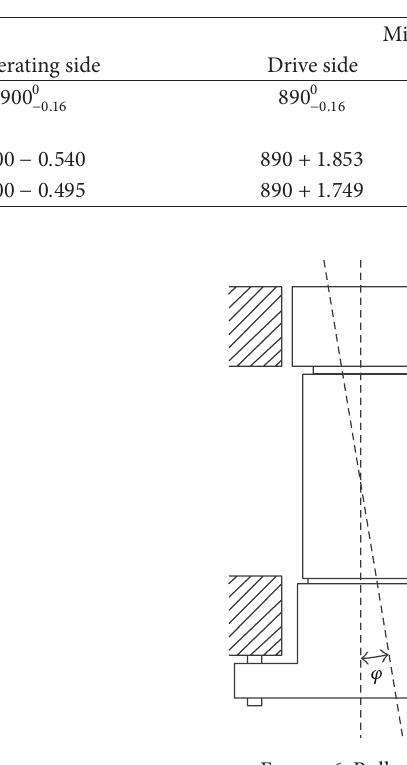
Figure 6: Roller